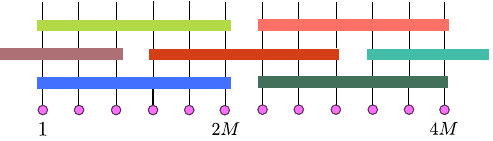
FIG. 8. Structure of the first few layers of the coarse-grained random circuit. Each gate acts on 2 M consecutive sites (the on- site Hilbert space is q ¼ 2 ) and subsequent layers are shifted by M sites. Every gate is an independently chosen random unitary, block diagonal with respect to the total charge on the 2 M sites and Haar random in each